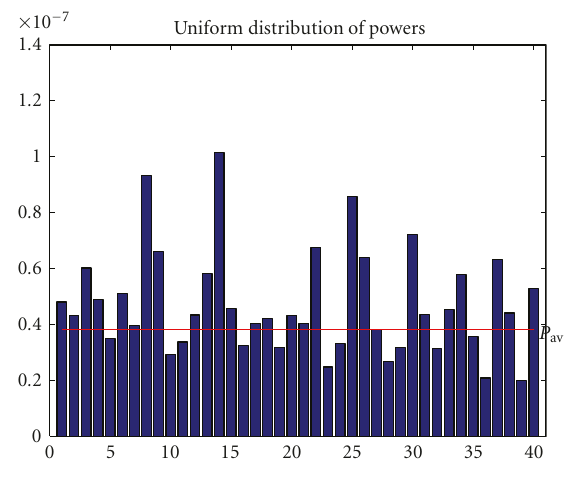
Figure 9: Energy per bit.